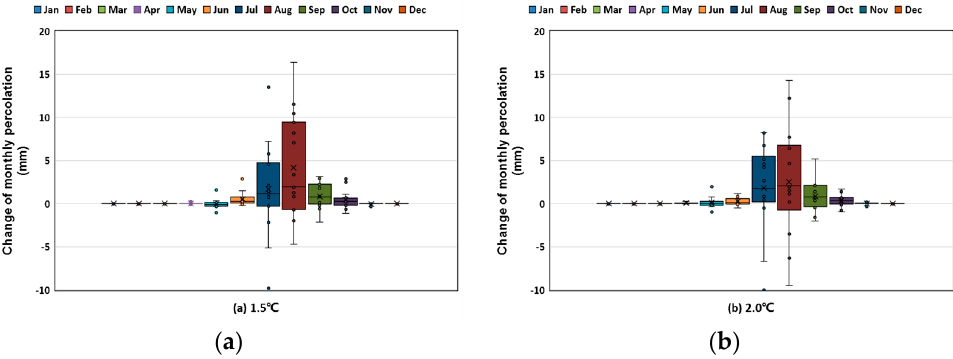
Figure 11. Change of monthly percolation refer to baseline period ( a ) 1.5 °C; ( b ) 2.0 °C.